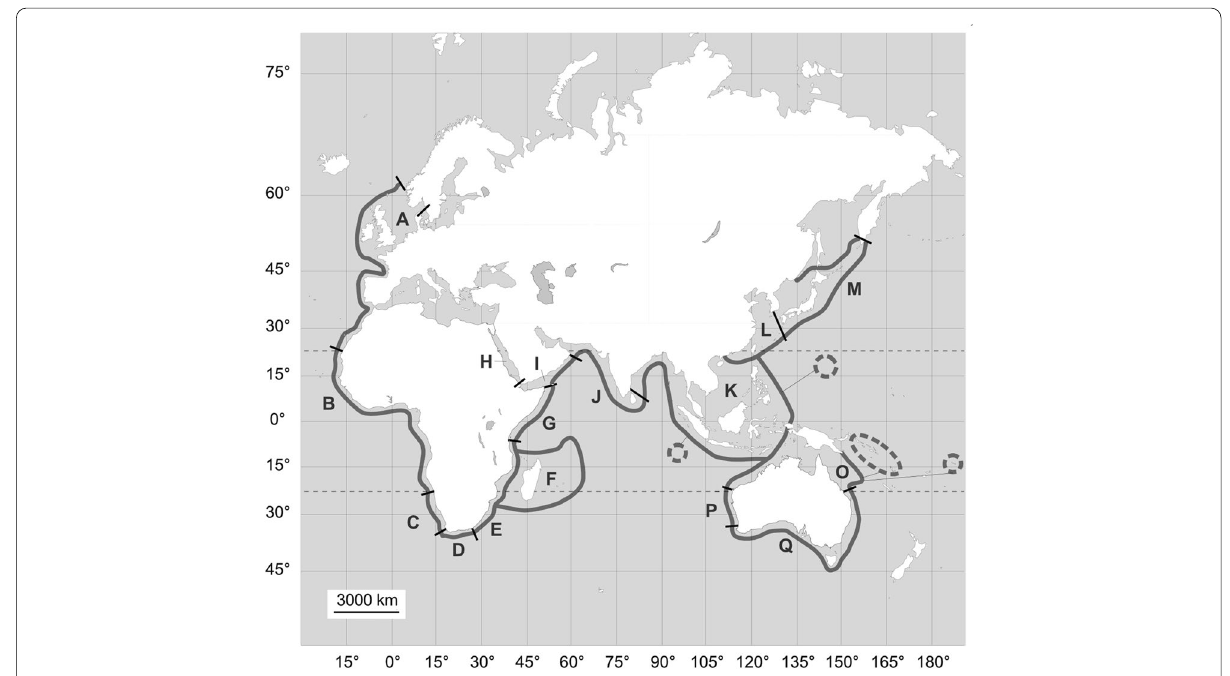
Fig. 2 Geographical distribution of sepiids and biogeographical units selected for this study